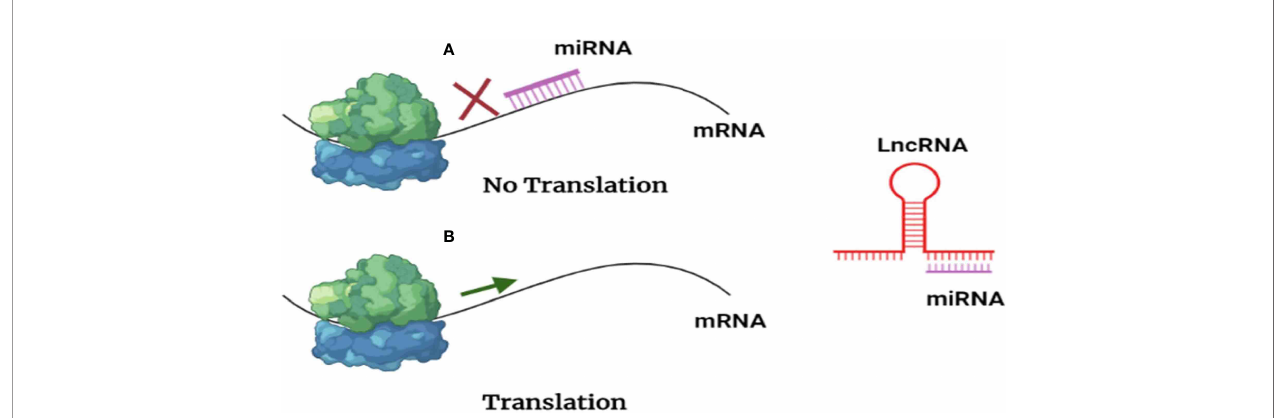
FIGURE 4 | Scheme presenting lncRNAs reversing the negative regulation exerted by miRNAs. (A) miRNAs inhibit translation by interacting with messenger RNA. (B) As lncRNAs act as a sponge for miRNAs, messenger RNA (mRNA) translation is